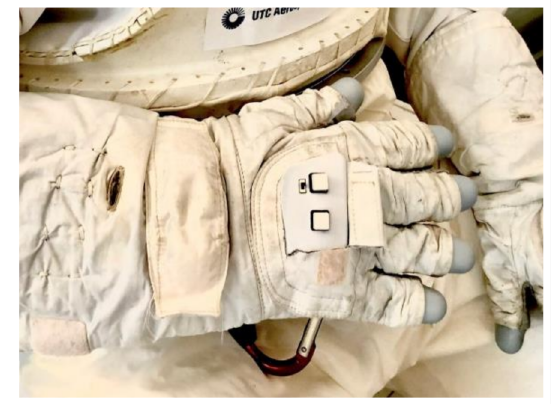
Figure 23. NASA (Ntention) –smart glove